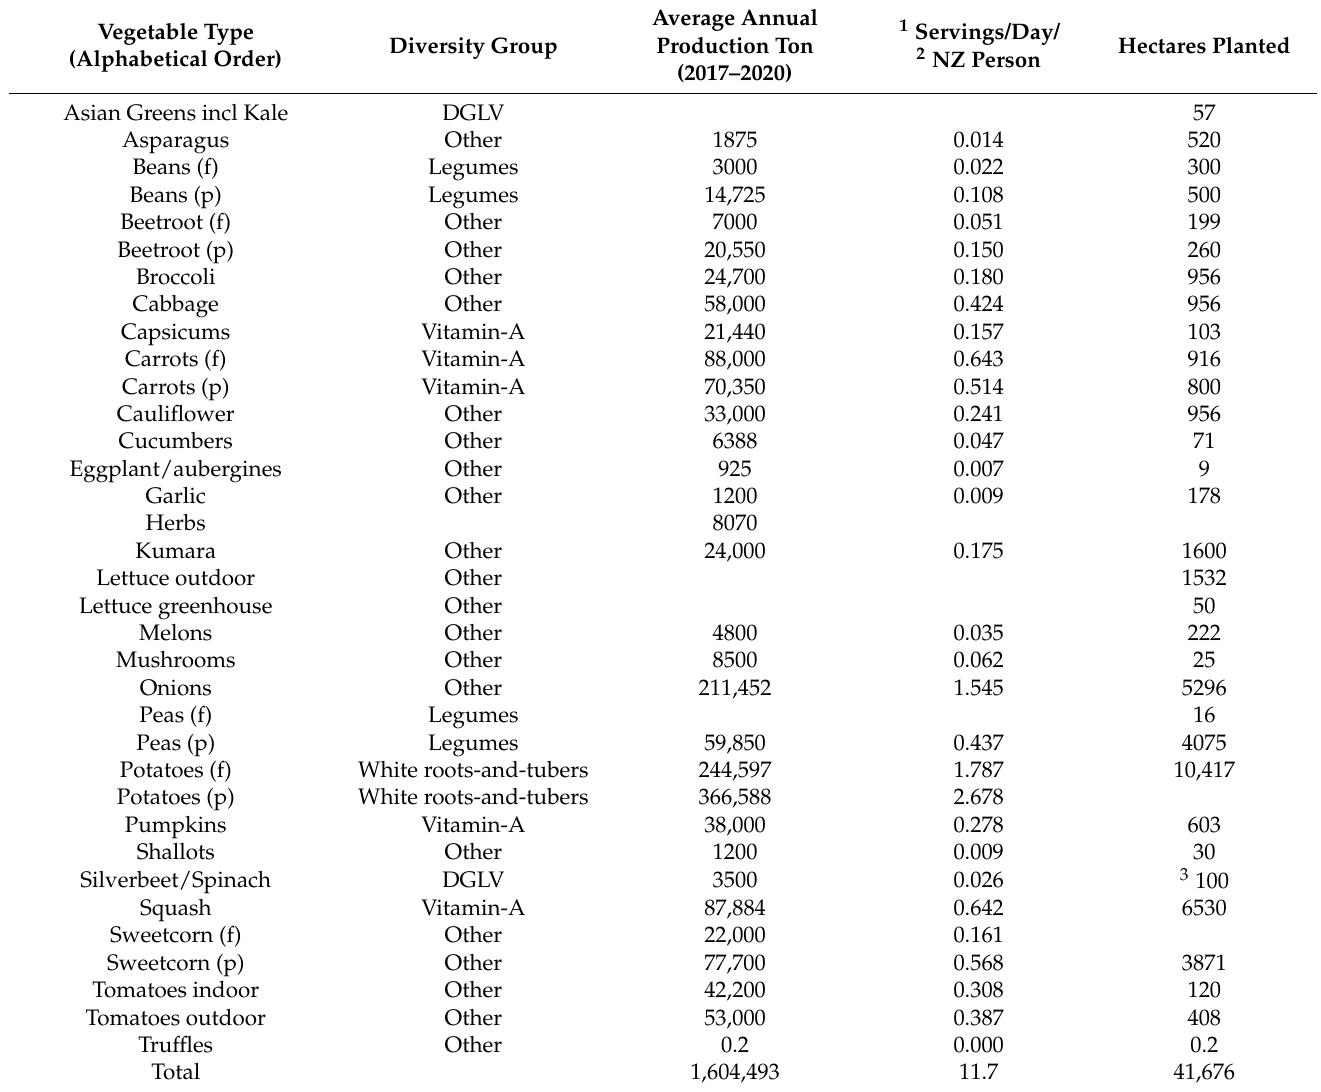
Table 1. Fresh and processed average vegetable production in tons 2017–2020 and hectares covered 2020 for New Zealand